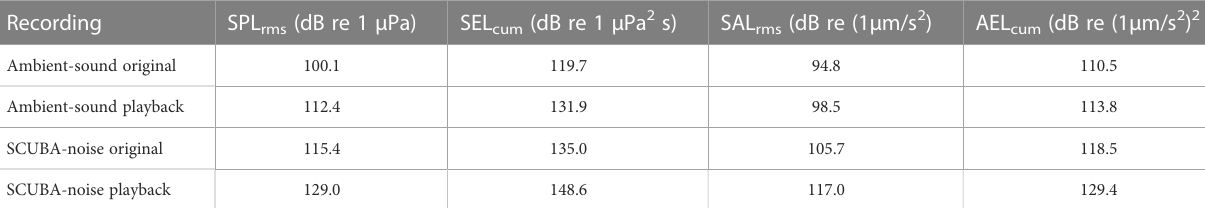
TABLE 1 Root-mean-square and cumulative sound-exposure levels in both sound pressure (SPL rms and SEL cum ) and triaxial particle acceleration (SAL rms and AEL cum ) for each recording